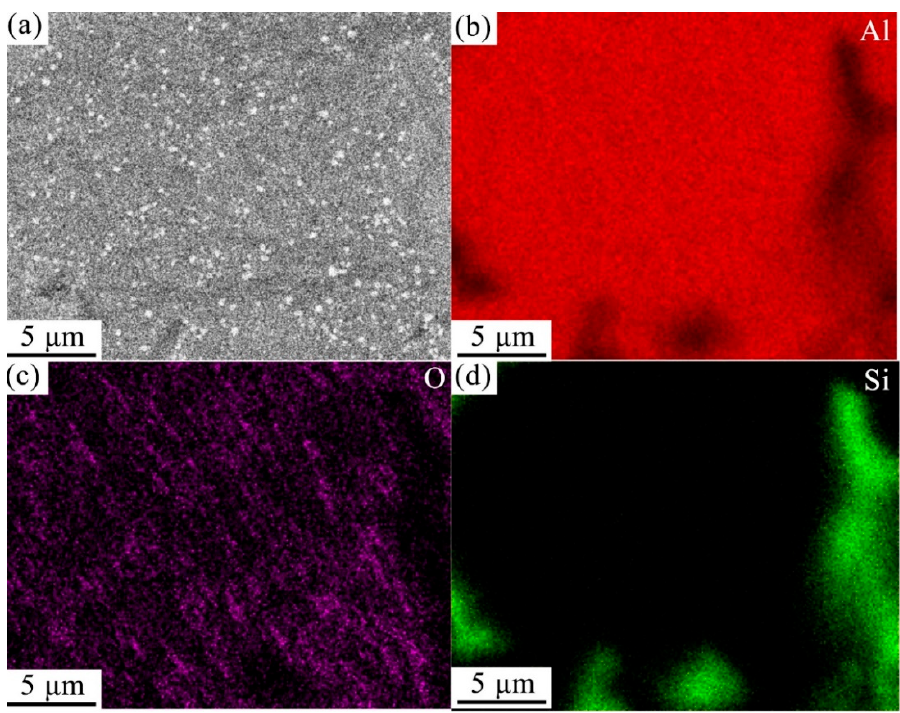
Figure 11. SEM image ( a ) and EDS images ( b – d ) of modi fi ed Al–20Si alloy.